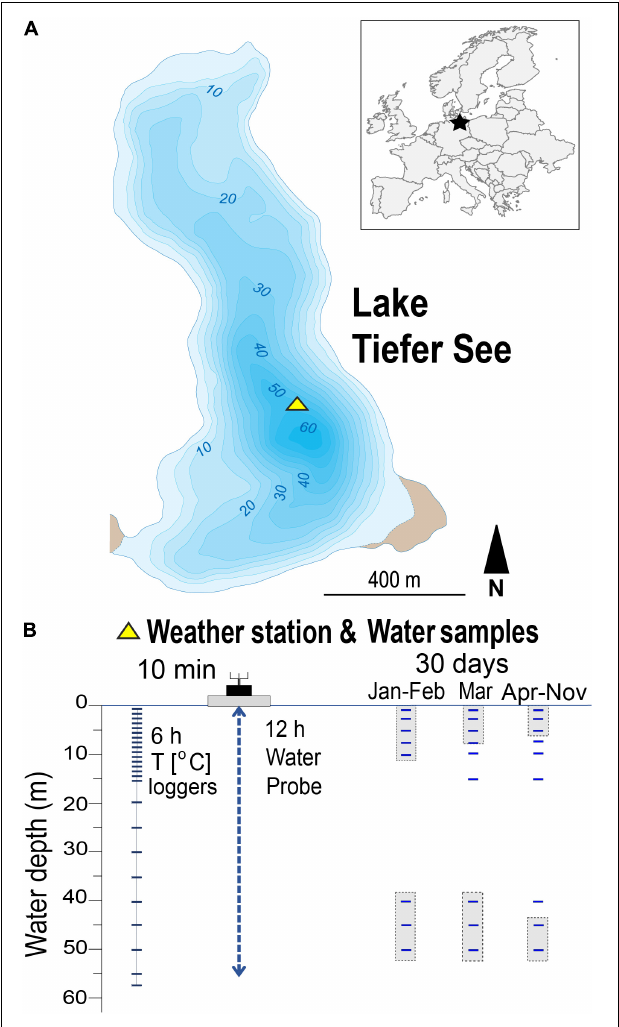
FIGURE 1 | Location of the study site and sampling setup. (A) Location of Lake Tiefer See near Klocksin (TSK, NE Germany). (B) Scheme of lake monitoring setup showing depths of water column temperature loggers and the depths from which water samples were taken. Shaded sampling points indicate samples that were pooled for genomic DNA